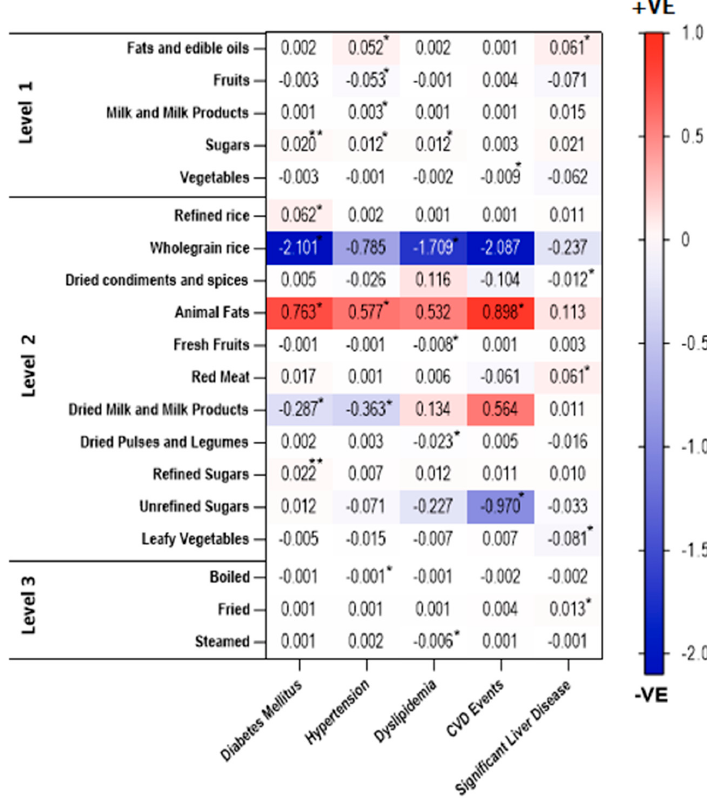
Figure 3. Heatmap showing positive and negative associations of the intakes of significant food groups with clinical outcomes amongst individuals with NAFLD. The axis represents the range of positive (red) and negative (blue) associations. p values adjusted for age, gender, and BMI (* p < 0.05; ** p < 0.001).